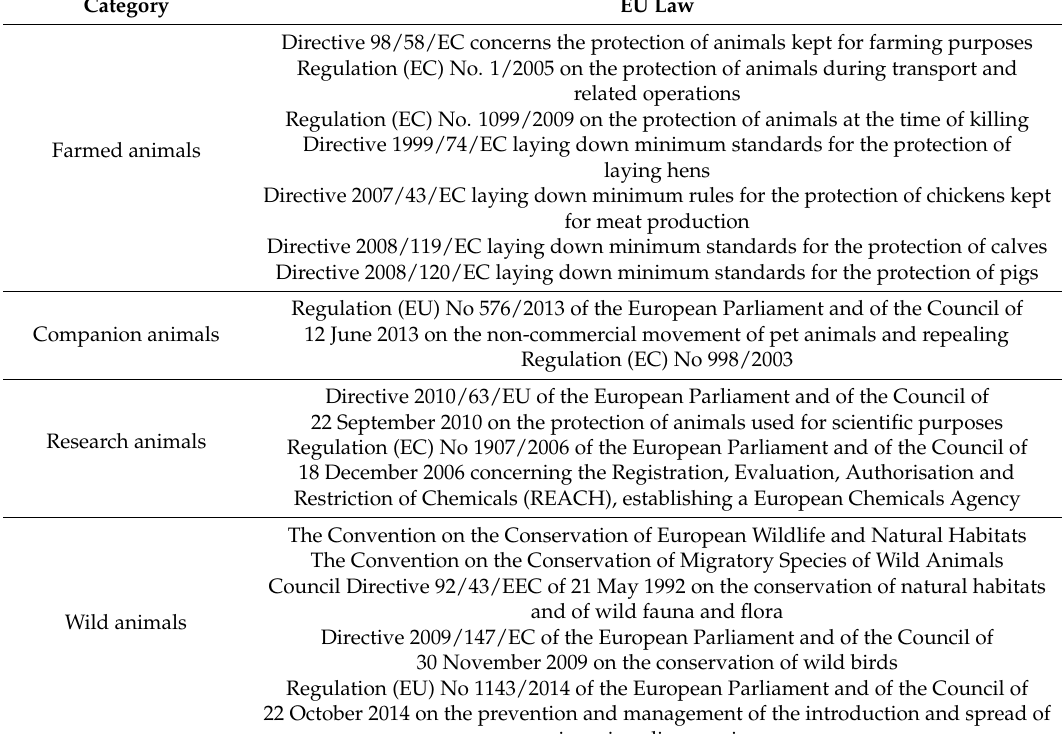
Table 3. Key EU animal protection